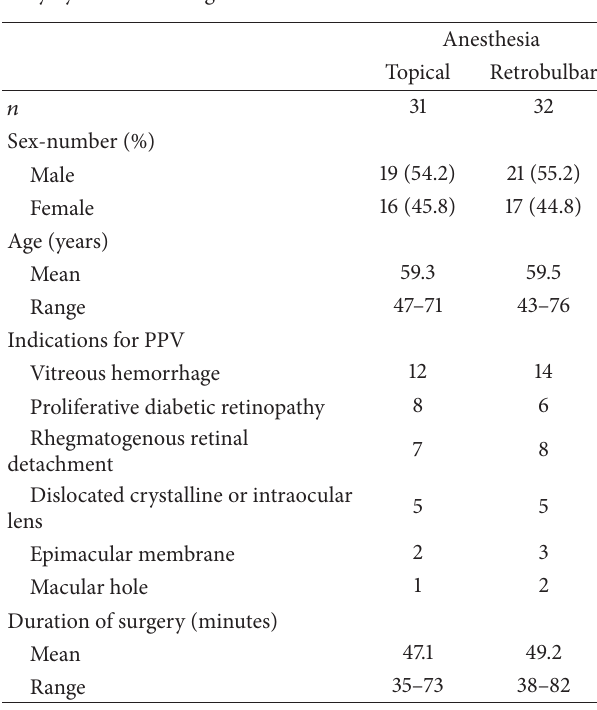
Table 2: Baseline patient characteristics and indications for vitrec- tomy by treatment assignment.